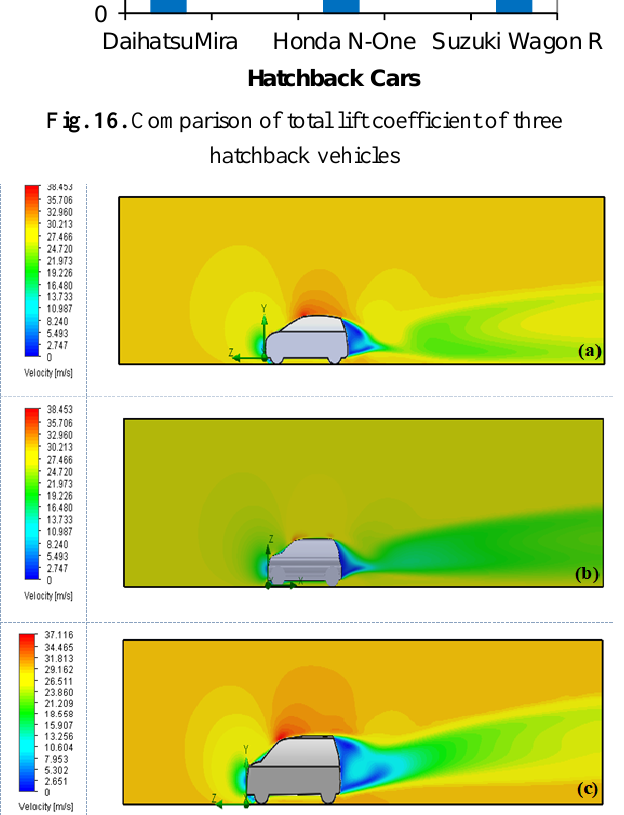
Fig. 17. Velocity contours of vehicles at 0 o diffuser angle for (a) Daihatsu Mira (b) Honda N-one (c) Suzuki Wagon R